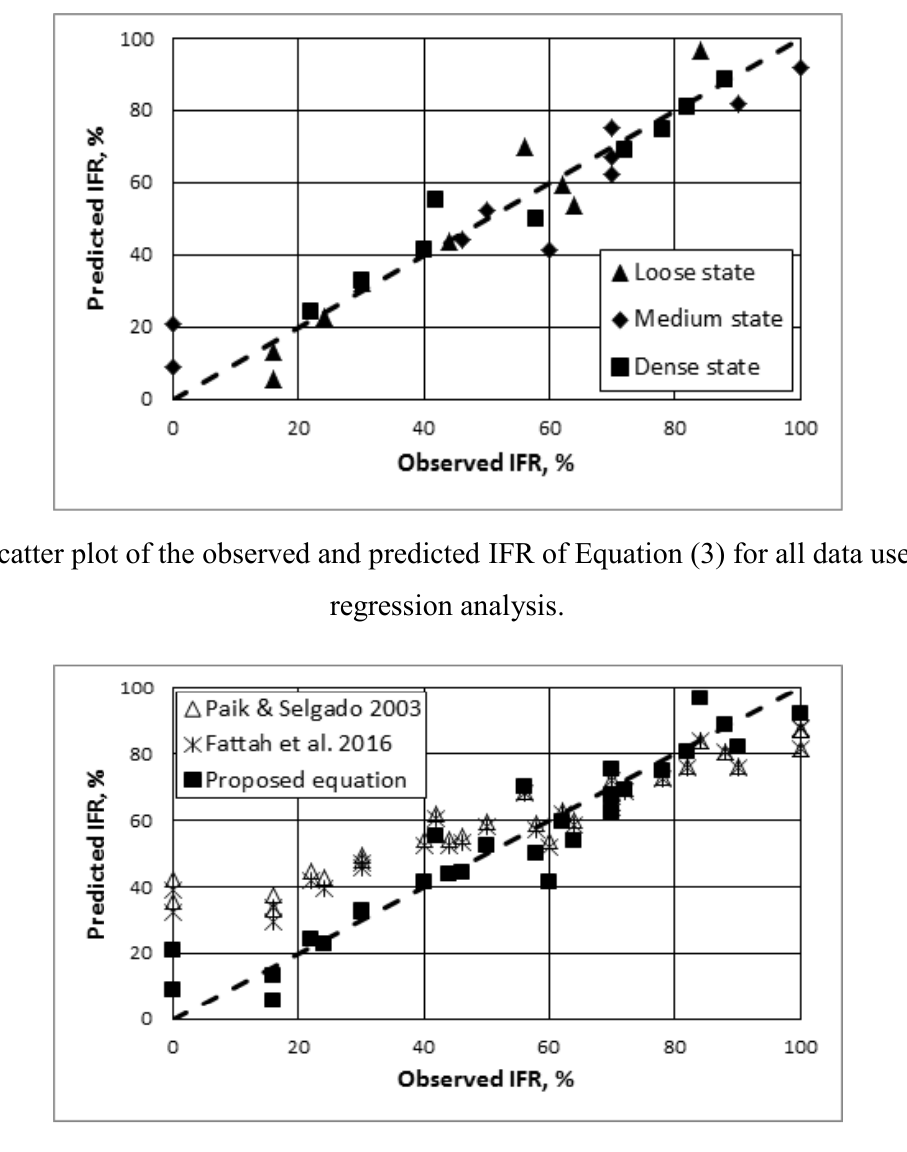
Fig. 5. Comparing the scatter plot of observed with the predict IFR for proposed and available